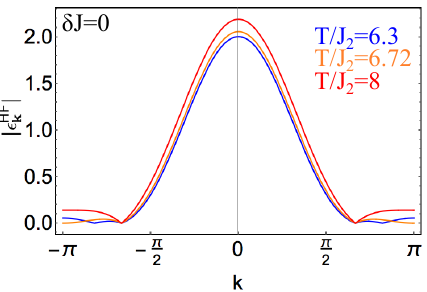
[ Eq. 85 ] at δ J = 0 and for varying temperature. The path through Figure 27: The spectrum ε HF k 2D reciprocal space is parametrised by k = ( k , k + π ) . In the paramagnet (red) there is a single gapless = 6.72 (orange) point in the region k > 0 and this occurs at an incommensurate wavevector. At T / J 2 the gap at k = ( π ,0 ) closes, but there remains a gapless point at an incommensurate wavevector. At lower T (blue) the gapless points approach one another, and the spectrum is very flat in their vicinity. While it is clear that the perturbative approach has broken down at such a small value of δ J / J , the 2 results are suggestive that lines of zeros appear in the spectrum, and this would be consistent with a first-order phase